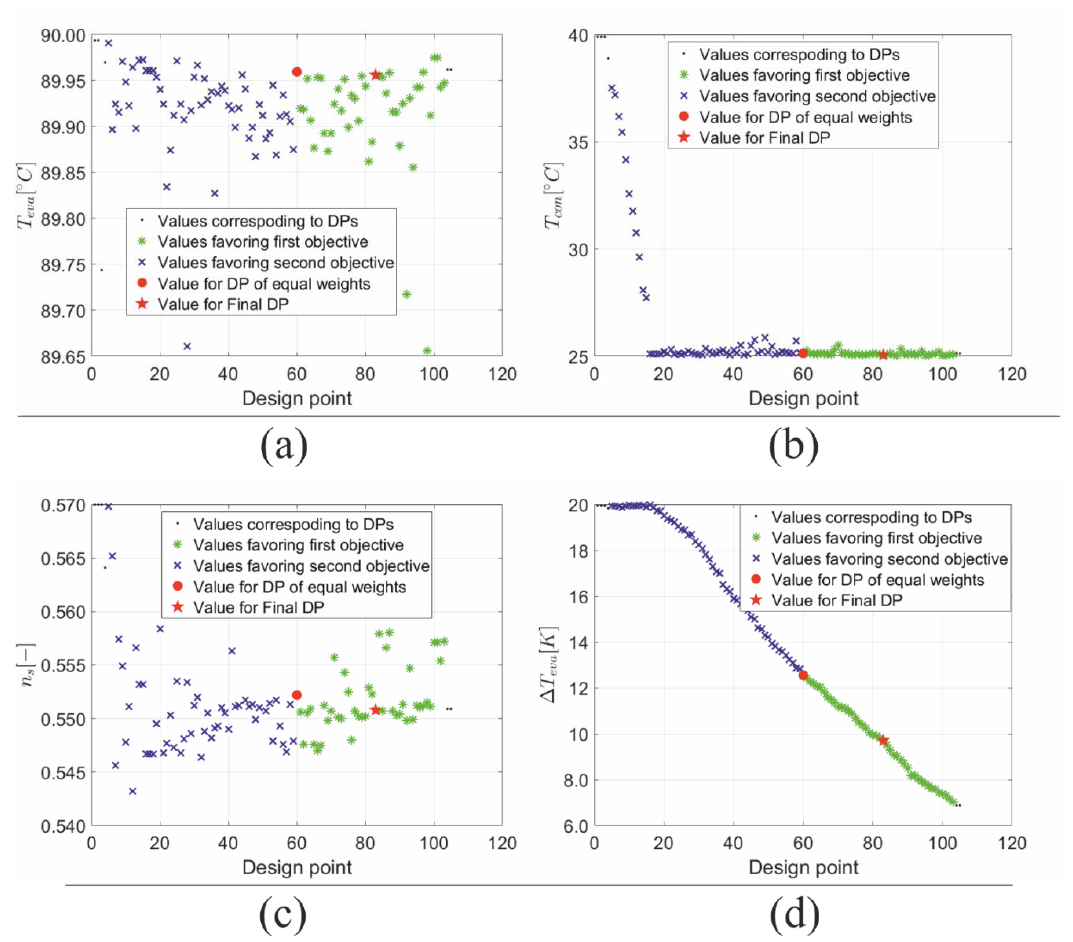
Figure 13. Scatter distribution graphs for the examined decision variables: ( a )—evaporation temperature T eva , ( b )—condensation temperature T con , ( c )—specific speed n s , ( d )—temperature difference ΔT eva.